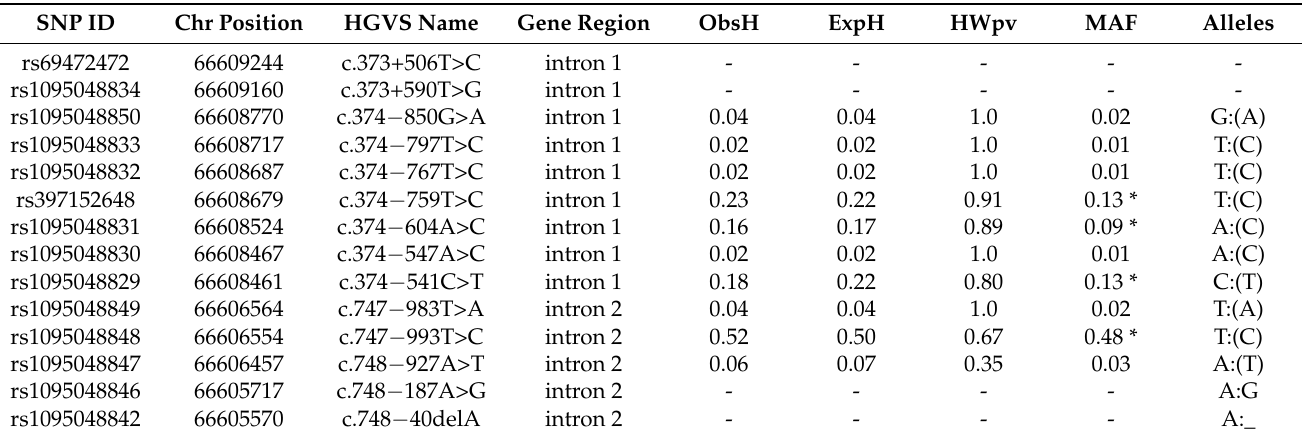
Table 1. SNPs at the equine MSTN gene in Anglo-Arabian horses ( n =